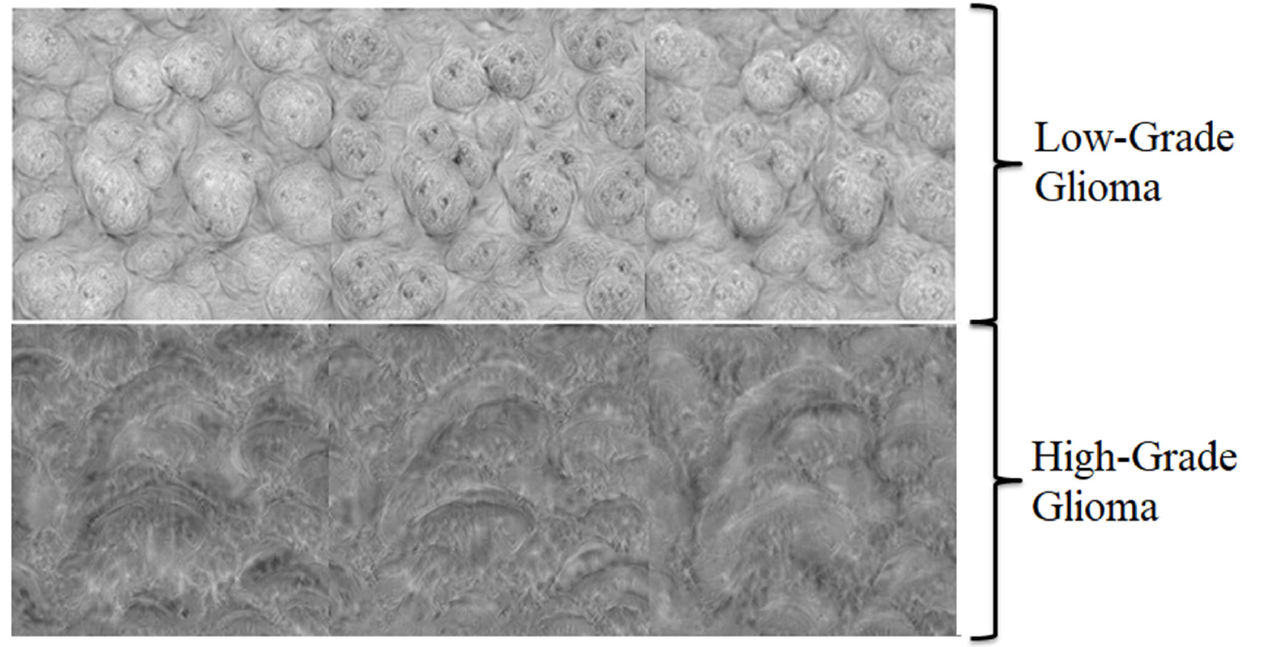
Figure A4. Heatmap diagram of head node for low-grade and high-grade glioma.